Question: Which kind of chart has been used to present this data?
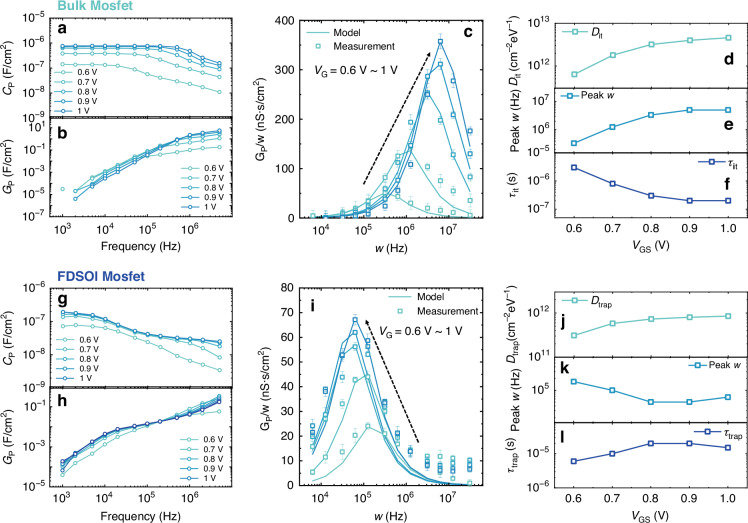
Answer: line